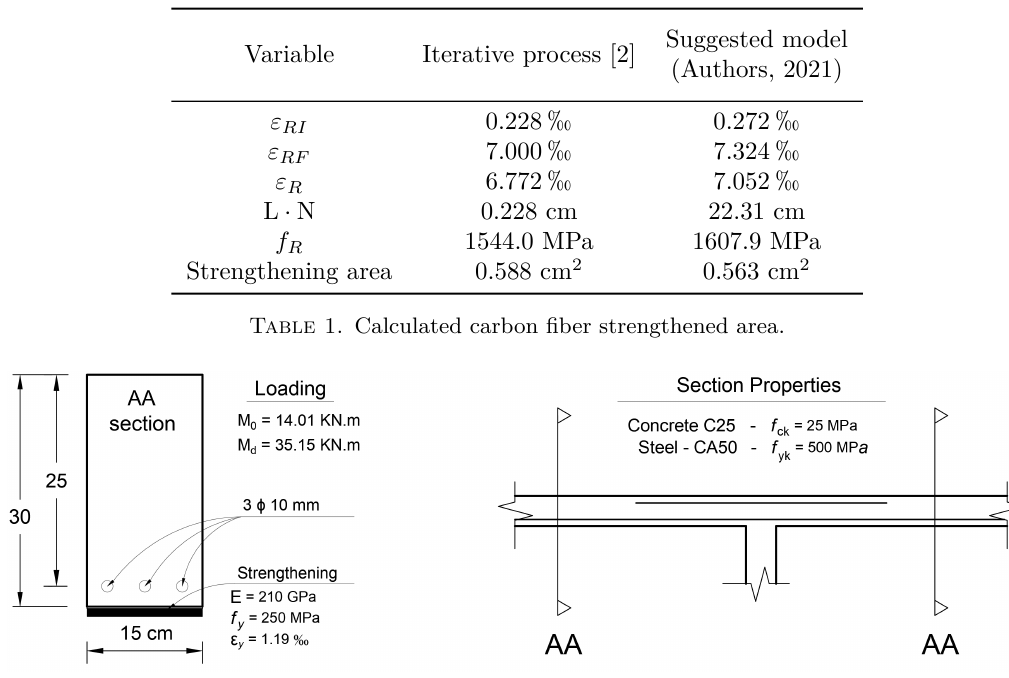
Figure 4. Representation of beam characteristics of the building.